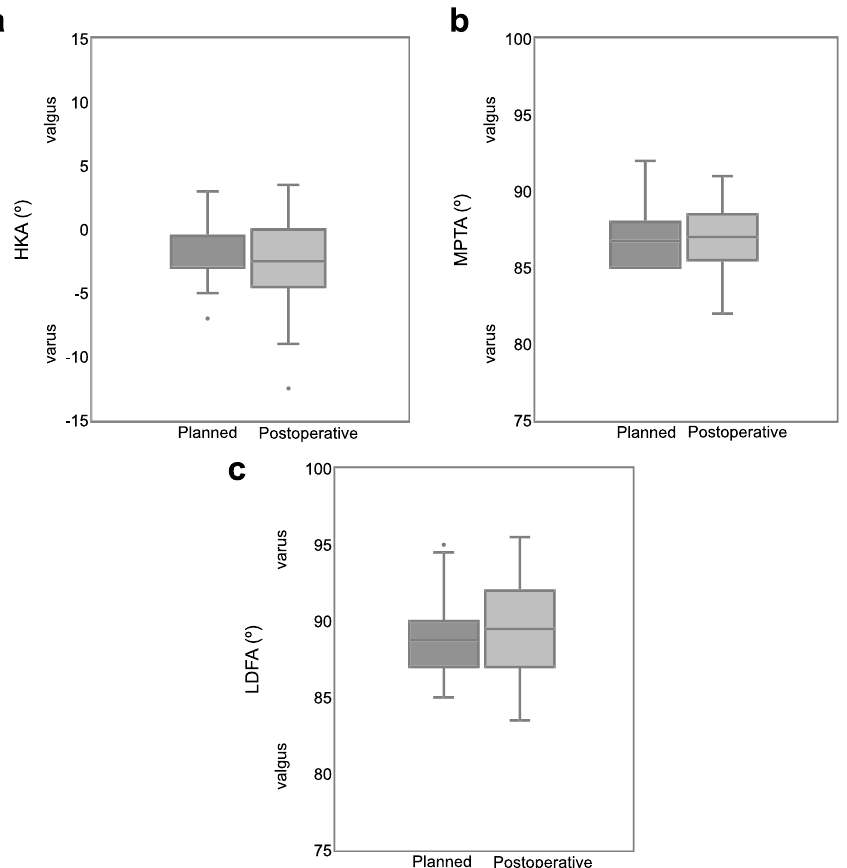
Fig. 7 Distributions of postoperative HKA, MPTA, and LDFA compared to the planned alignment. a HKA. b MPTA. c LDFA. Abbreviations: HKA: hip-knee-ankle angle; LDFA: lateral distal femoral angle; MPTA: medial proximal tibial